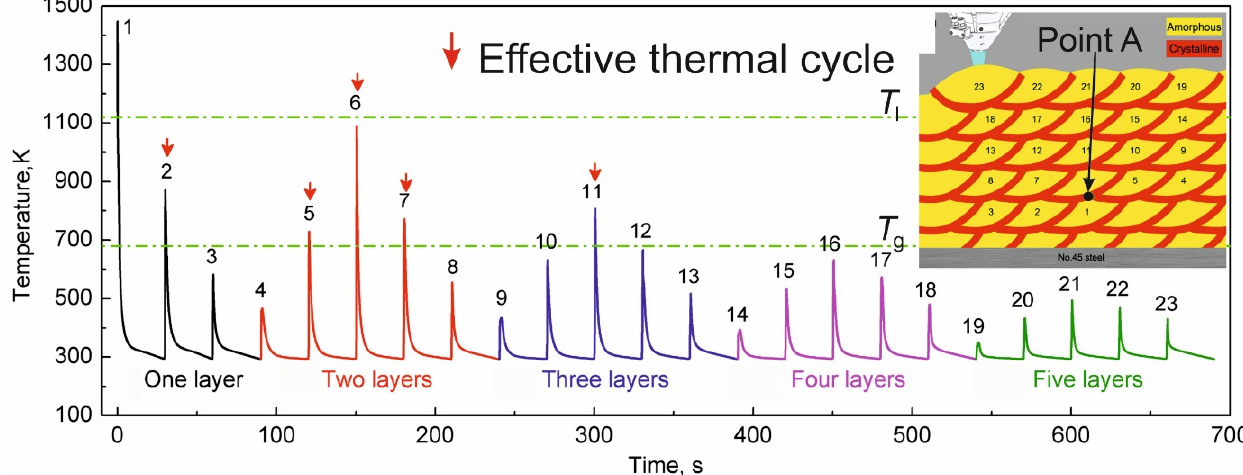
Figure 30. Thermal cycles extracted from FEM simulations of the DED process on a Zr-based BMG. The inset shows the schematic of the process and the location at which these thermal cycles were computed. Modified from [98], with permission from Elsevier, 2021.